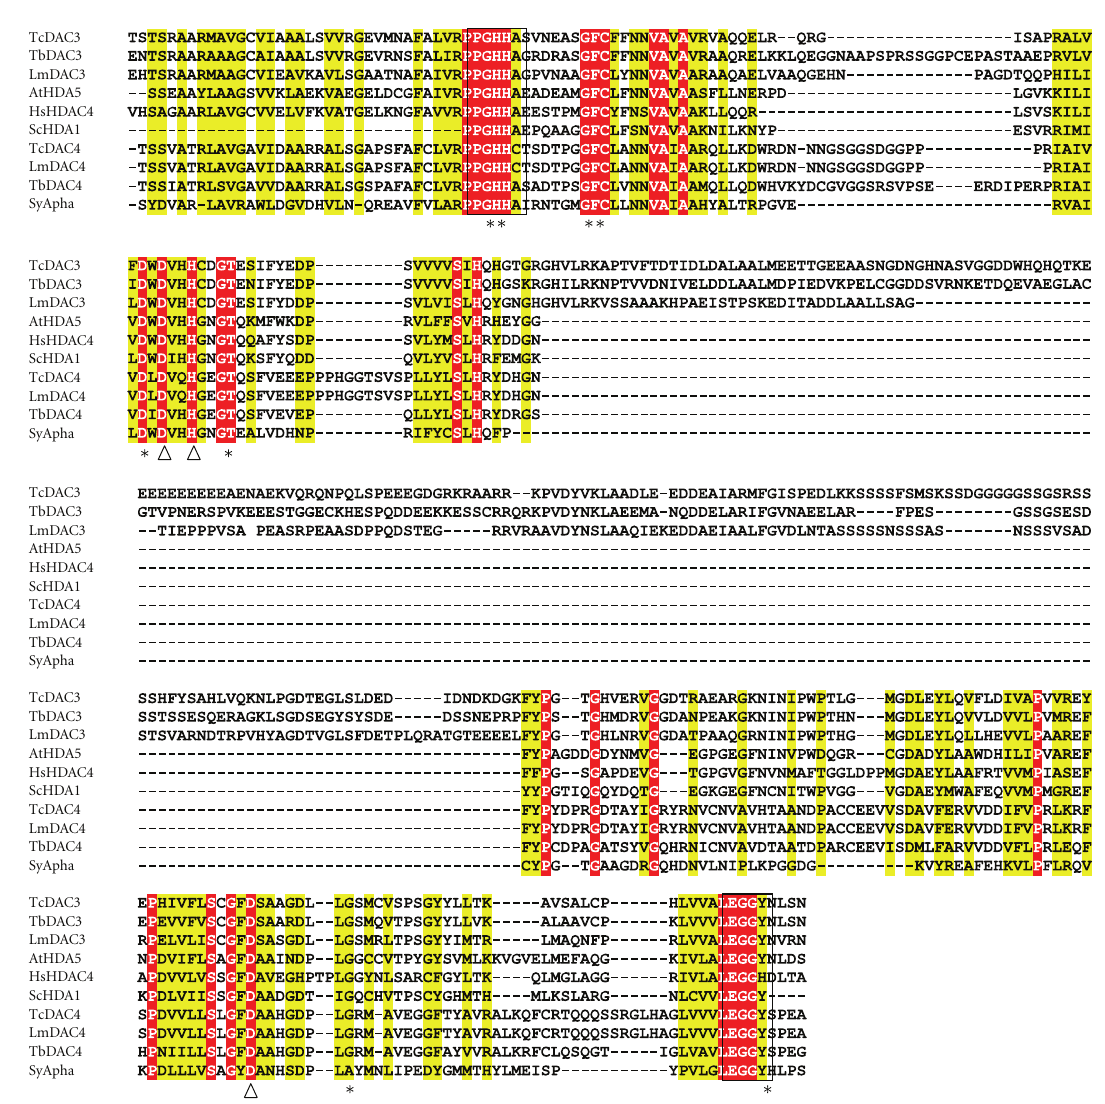
Figure 4: Class II deacetylases orthologues in trypanosomatids. Alignment of the core deacetylase domain from di ff erent organisms. Sequences were aligned using ClustalX and were adjusted manually and illustrated with ESPript 2.2. The black boxes indicate the class- specific motif. Identical residues are white on red background, and residues shared by some organisms are black on yellow background. Asterisks indicate residues that were predicted to form part of the catalytic pocket, whereas triangles indicate zinc cofactor ligands. Tb, Trypanosoma brucei ; Tc, Trypanosoma cru zi; Lm, Leishmania mayor; At, Arabidopsis thaliana ; Hs, human; Sc, Saccharomyces cerevisiae; Sy, Synechocystis spp.; AphaA, acetylpolyamine